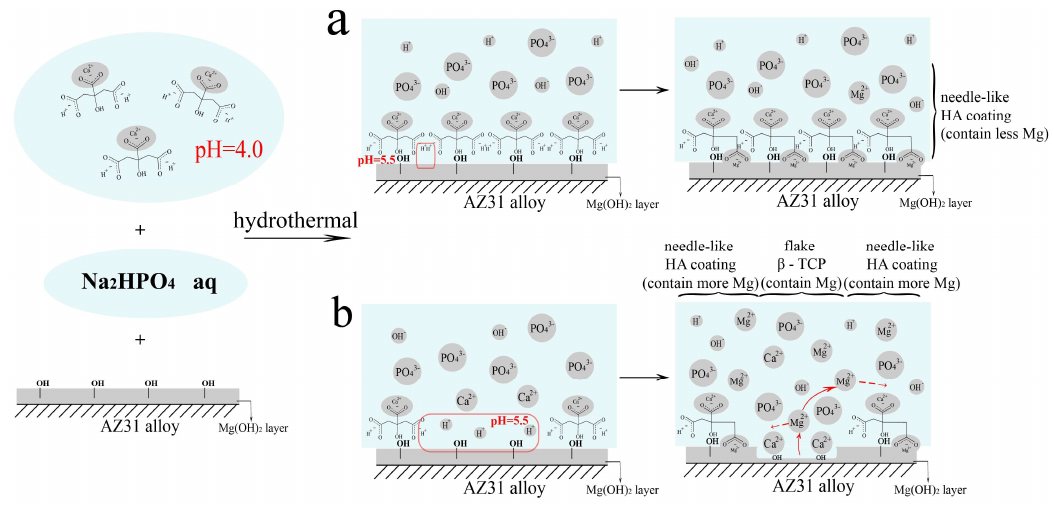
Figure 5. Schematic illustrations showing the sodium citrate control mechanisms of Ca-P coating. ( a ) CN1; ( b ) CN4-CN13.